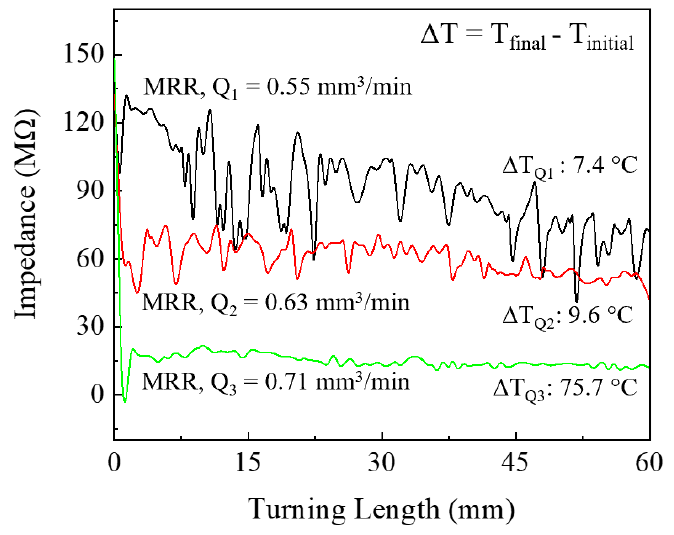
Figure 9. Impedance monitoring results during the turning